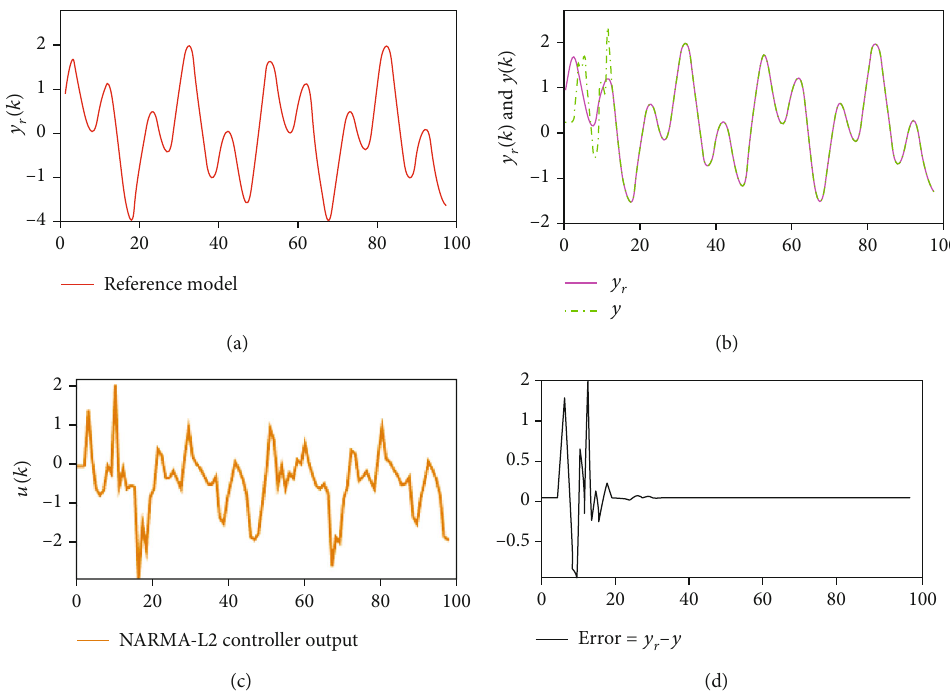
Figure 7: Example 1: (a) response of the reference model, (b) outputs of the reference model and the plant with control action, (c) NARMA- L2 controller output, and (d) control